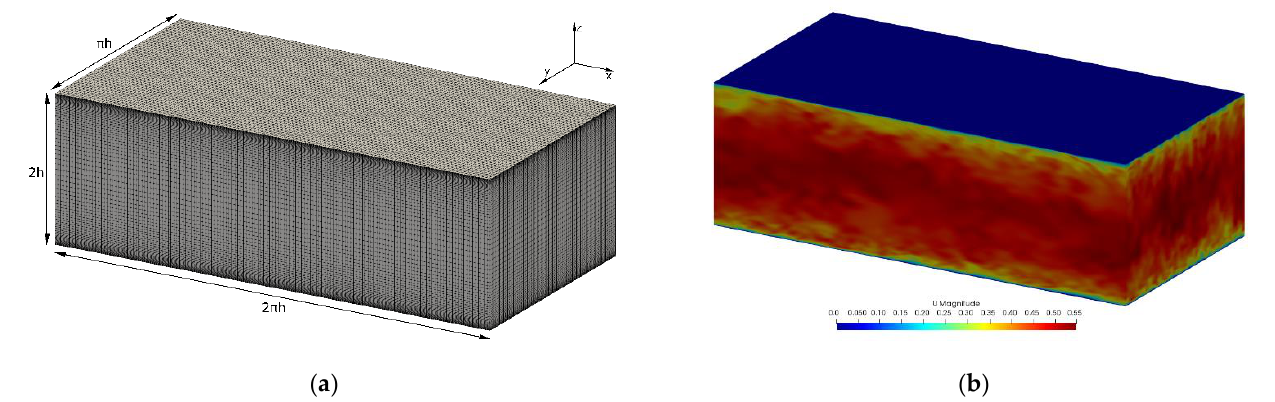
Figure 2. Grid and computational domain employed in the LES simulation using periodical flow. ( a ) Grid distribution and dimensions of the computational domain, ( b ) sample of LES velocity magnitude (m/s) at a given time step.